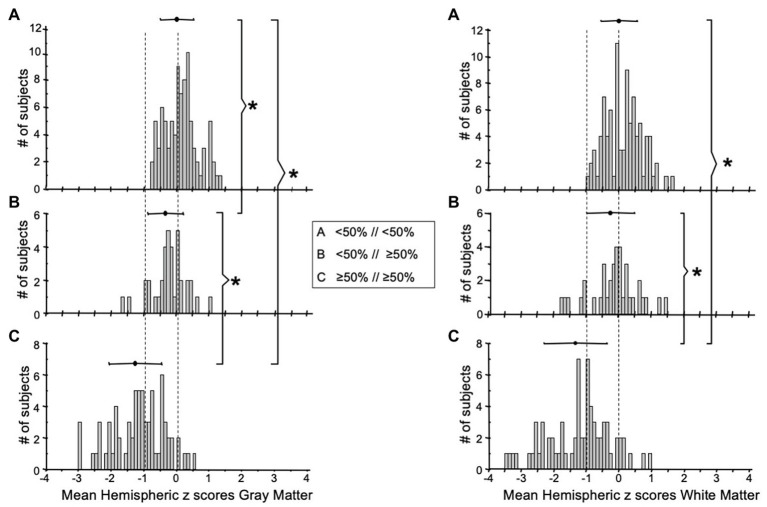
FDH of the mean MCA hemispheric z scores distribution of gray (left side graphs) and white matter (right side graphs) with (A) both hemispheres <50% stenosis, (B) one hemisphere ≥50% stenosis with the other hemisphere <50% stenosis, and (C) both hemispheres with ≥50% stenosis. *Indicates significantly different distributions. FDH, frequency distribution histograms; MCA, middle cerebral artery.